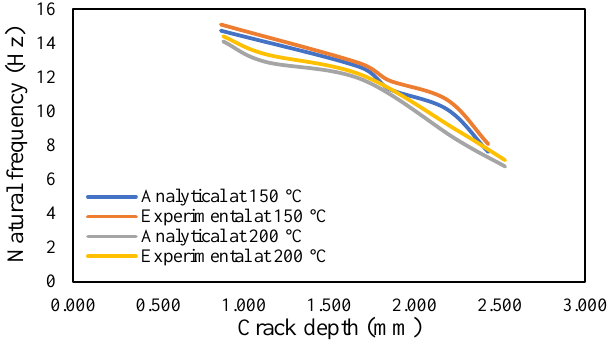
Figure 33. Comparison of the natural frequency of the propagated crack at an isothermal temperature of 150 and 200 °C.